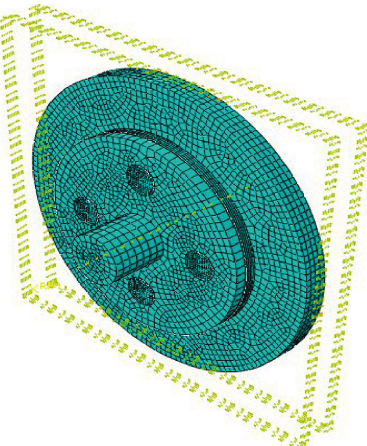
Figure 14: Meshing of the damper.